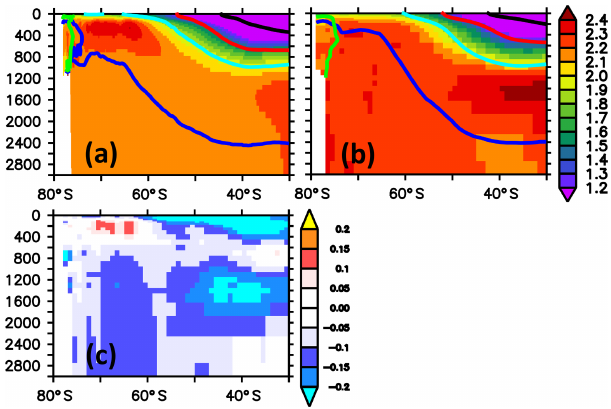
Figure 26. Zonally averaged meridional section of phosphate con- centration in units of mmolPm − 3 . Panel (a) refers to simulated concentrations averaged over the nominal 1993–1998 period of the reference simulation; (b) refers to observed climatological concen- trations (WOA09); (c) refers to the difference between simulated and observed concentrations, with blue colors denoting modeled concentrations that are biased low. The thick black, red, cyan, blue and green contours refer to mean densities (Sallée et al., 2013b, their Table 2) of subtropical water, mode water, intermediate water, circumpolar deep water and bottom water, respectively.